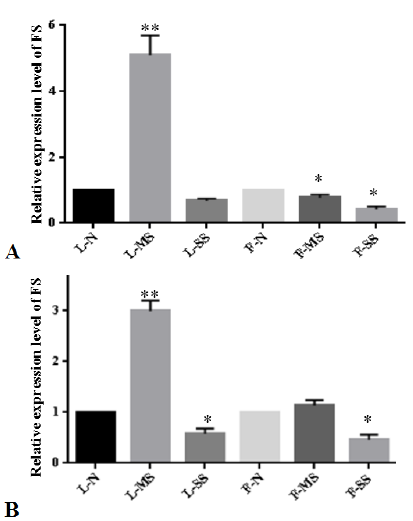
Fig. 2. The relative gene expression: The expression of Flavone synthase gene under drought stress condition relative to control condition in leaves and flowers of Ardakan (A) and Taybad (B) ecotypes. L: leaf; F: flower; N: normal irrigated condition; MS: moderate stress; SS: Severe